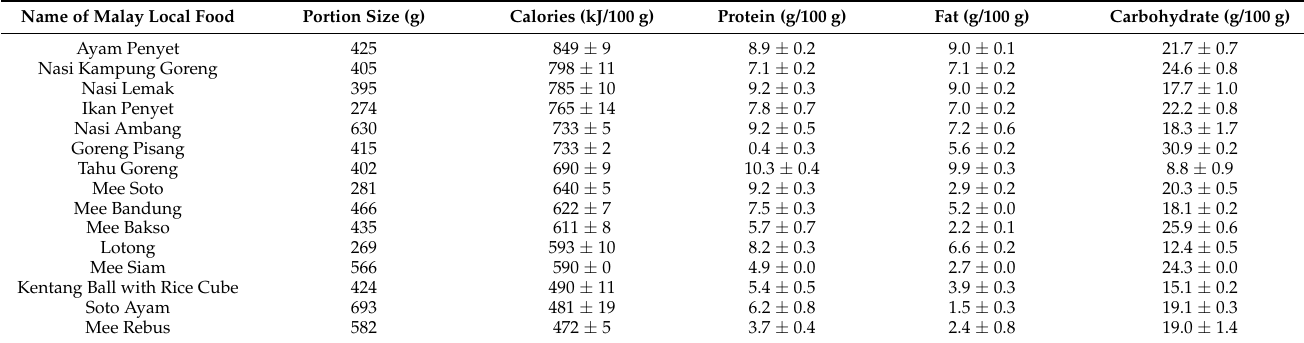
Table 2. Energy and macronutrient content of the commonly consumed Malay cuisines.